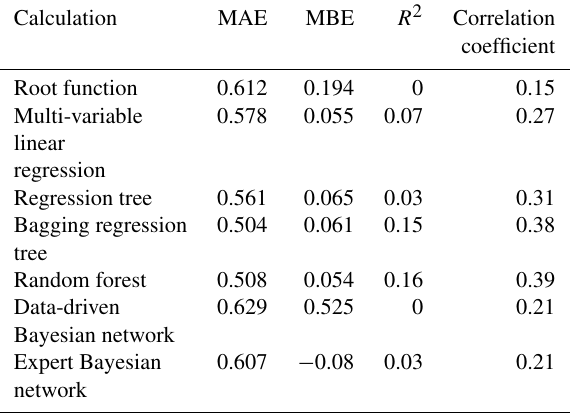
Table 2. Results of different models for four indicators: MAE, MBE, R 2 and correlation coefficient. The models had access to all variables (except for the root function). The version of the data set with the water depth rank join between the old and the new variables is